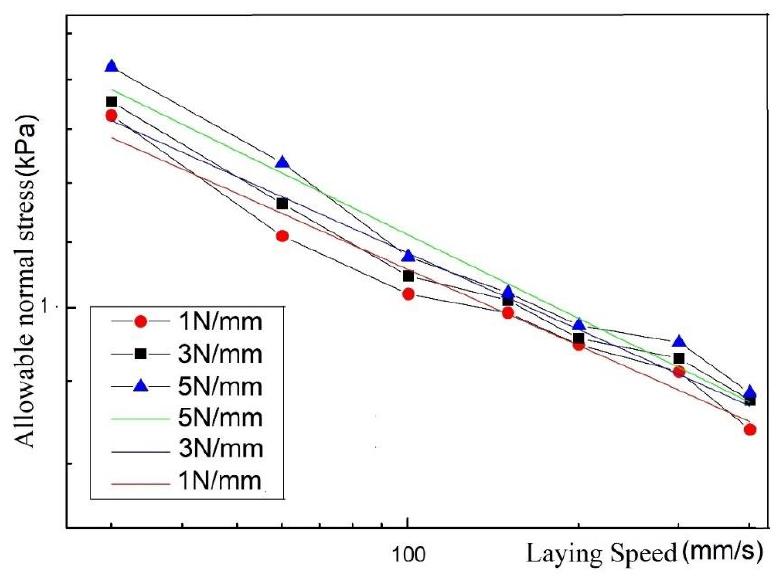
Figure 17. Laying speed/allowable normal stress logarithmic curve of prepreg/metal laminate.